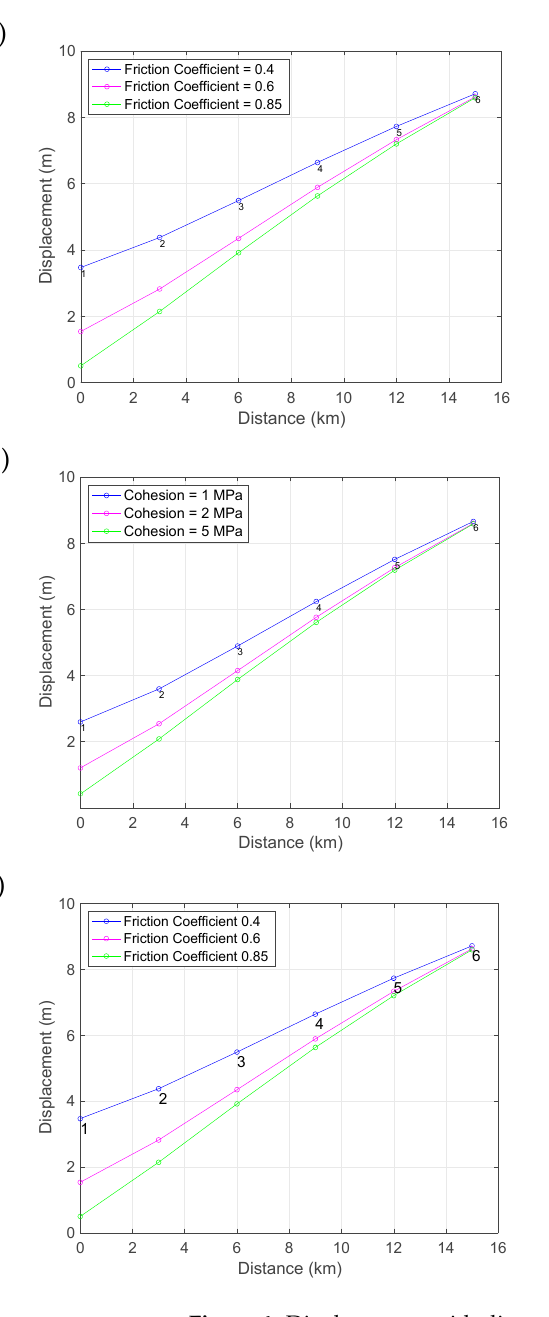
Figure 4. Displacement with distance from the fault of strain buildup model at year 250 based on different friction coefficients and cohesion values in three scenarios: ( a ) scenario one, ( b ) scenario two, and ( c ) scenario three. The differential stress values at the center and the boundary of each layer of the reference model are plotted in Figures 6 and 7, respectively. In accordance with the displacement and slip, the impact of the friction coefficient on the differential stress is higher than the cohesion. Interestingly, the variations in the friction coefficient and cohesion used in the viscoelastic layer only caused a negligible impact on the modeled differential stress. This shows that the friction coefficients and cohesion used did not affect the viscoelastic material significantly in the lower crust and upper mantle. It was mainly because the lower crust and upper mantle is more plastic, and the upper crust is more brittle. Therefore, the impact of friction coefficient and cohesion is more significant in the upper crust. As for the reference model, we found that continuous loading increases the differential stress at